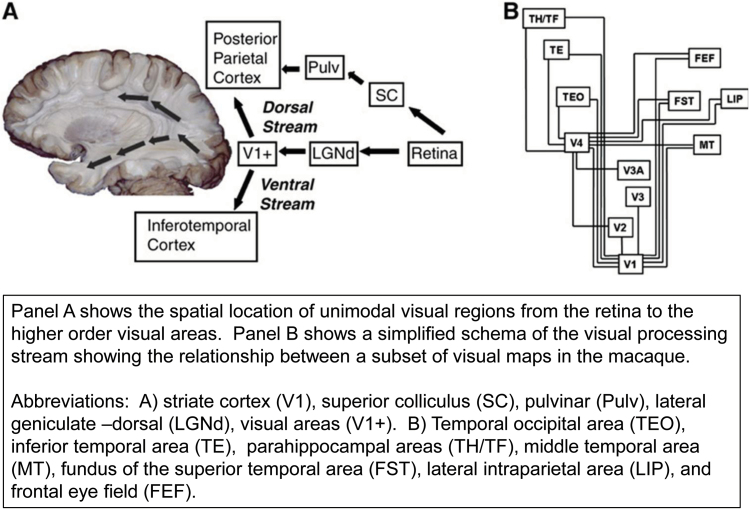
Visual areas from Wandell.17